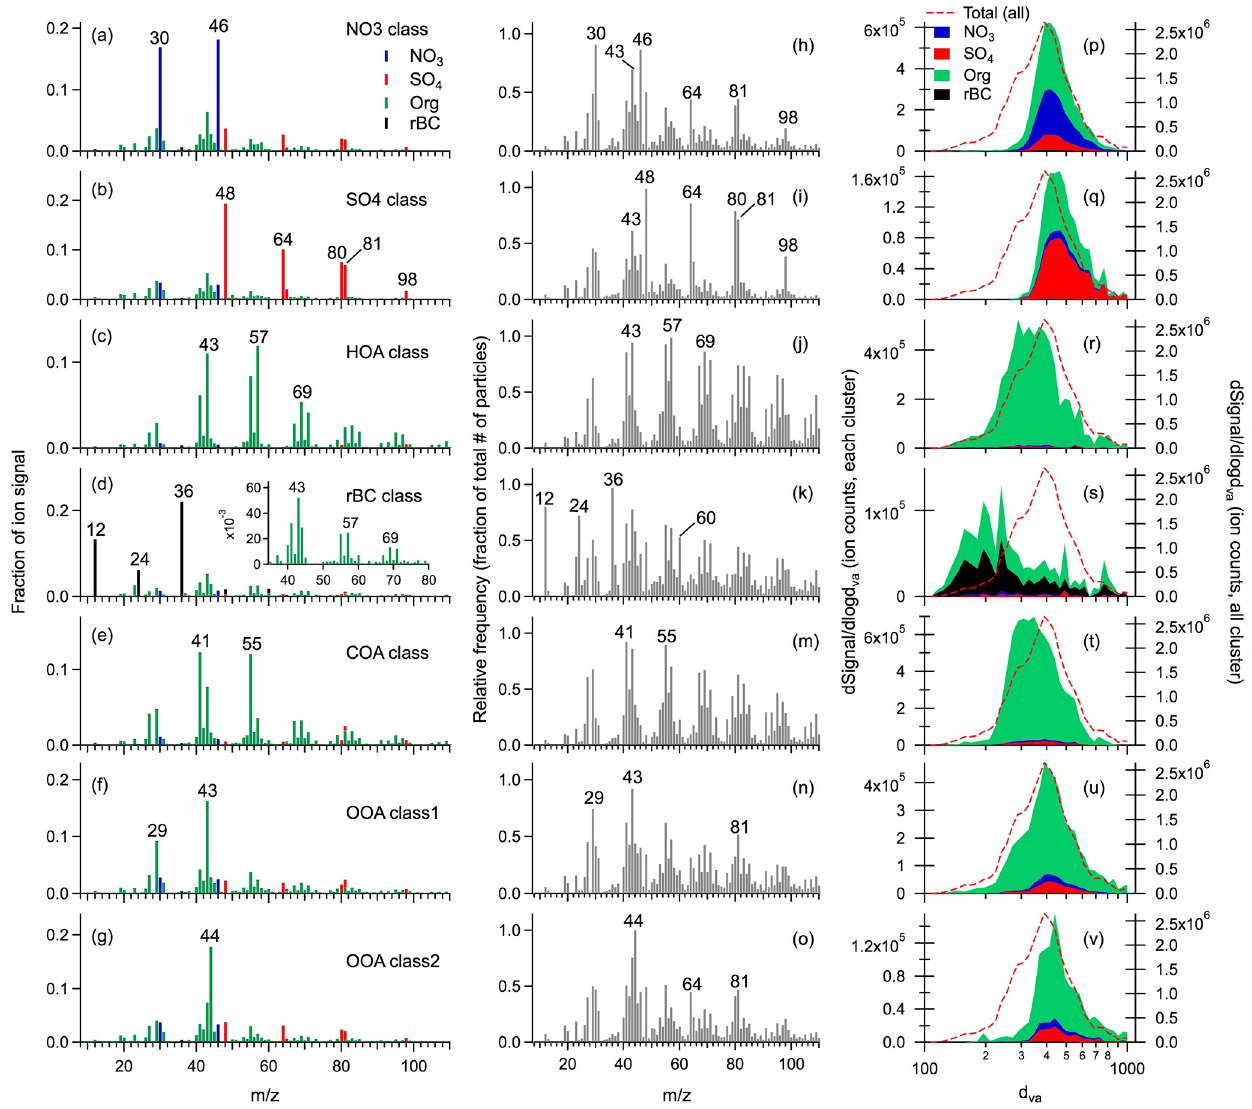
Figure 8. Normalized mass spectra (left column), normalized histograms displaying the relative frequency of each m/z (middle column), and size distributions (right column) of different particle classes identified from k -means clustering of LS-SP-AMS single particle data set (laser-on): ( a , h , p ) NO 3 class, ( b , i , q ) SO 4 class, ( c , j , r ) HOA class, ( d , k , s ) rBC class, ( e , m , t ) COA class, ( f , n , u ) OOA class 1 – less oxygenated, ( g , o , v ) OOA class 2 – more oxygenated. The insert in (d) shows the organic mass spectrum associated with rBC-rich particle